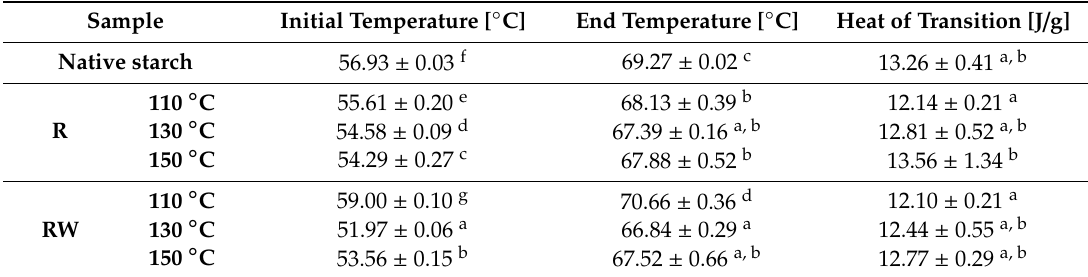
Table 1. Parameters of the phase transition of the native and modified starch preparations determined from thermal characteristics (DSC).